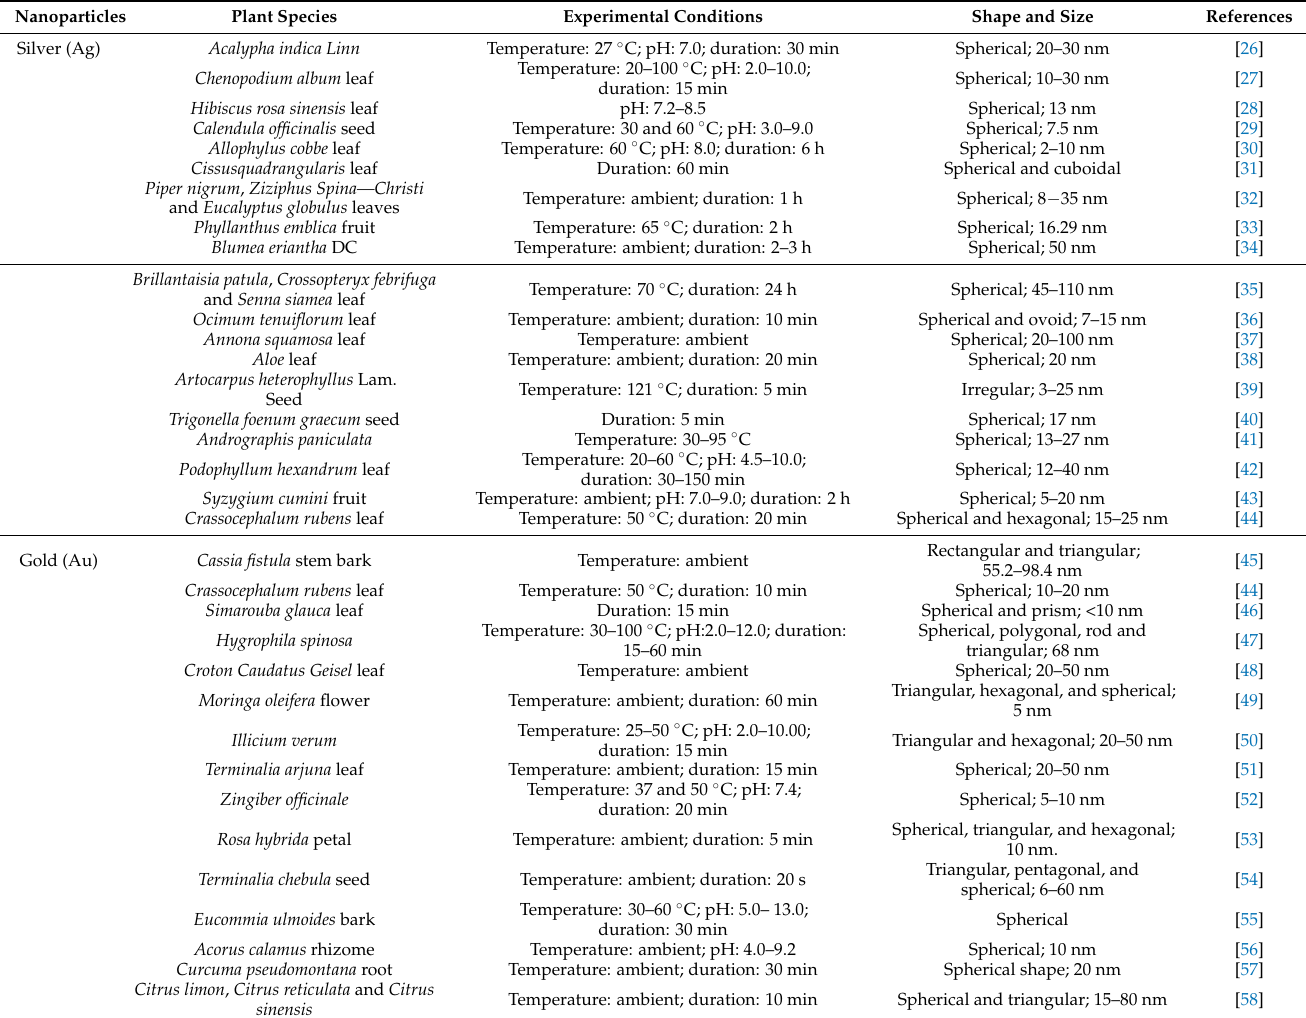
Table 1. Summary on synthesis of metallic nanoparticles by various plant